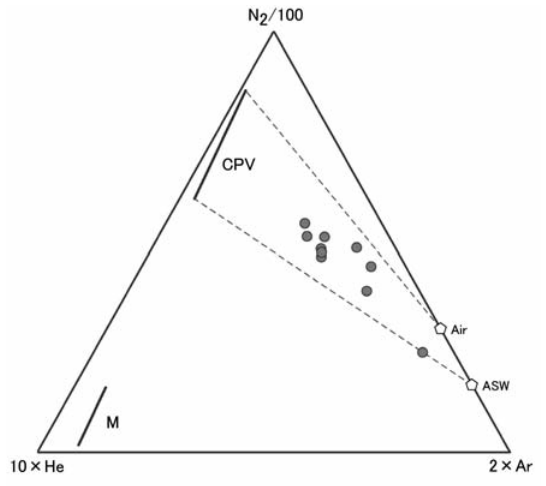
Figure 5. N -He-Ar ternary diagram showing the compositions of the 2 fumarolic gases at site J (molar basis). Circum-Pacific volcanoes (CPV) and M, end members typical of the CPV gases and gases originating in the mantle, respectively. ASW , composition of the water saturated with air. The data are plotted from Table 1.